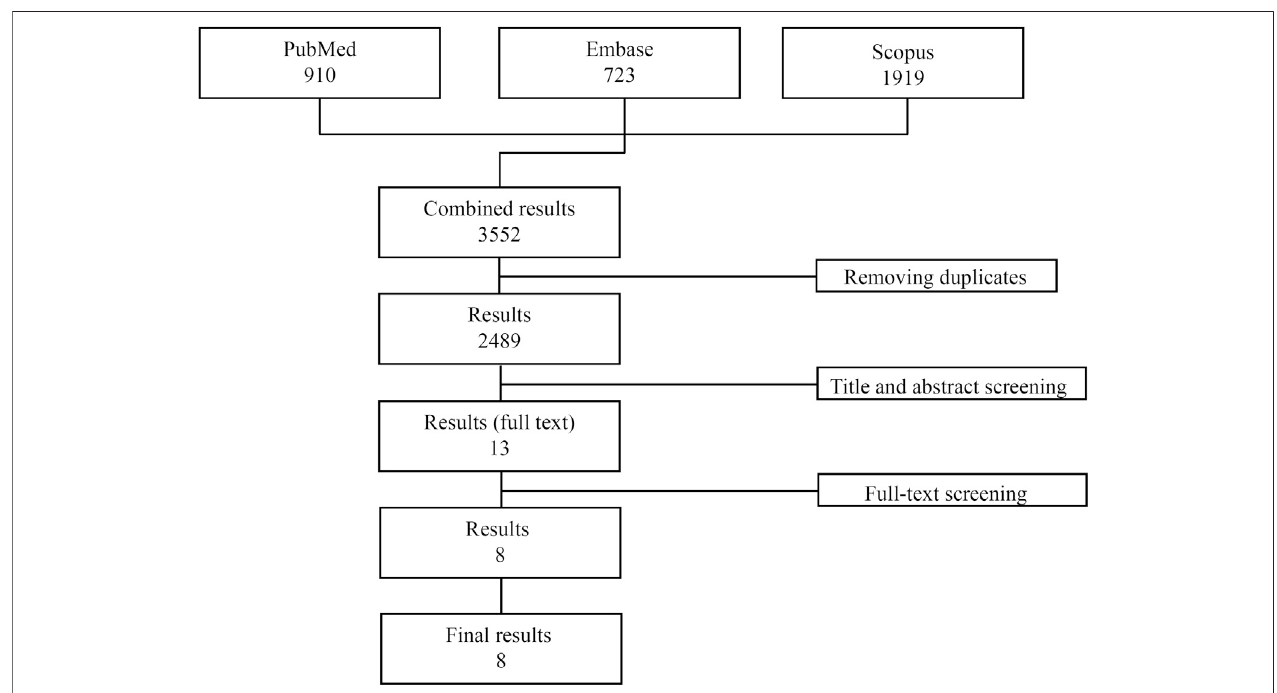
FIGURE 1 | Study fl